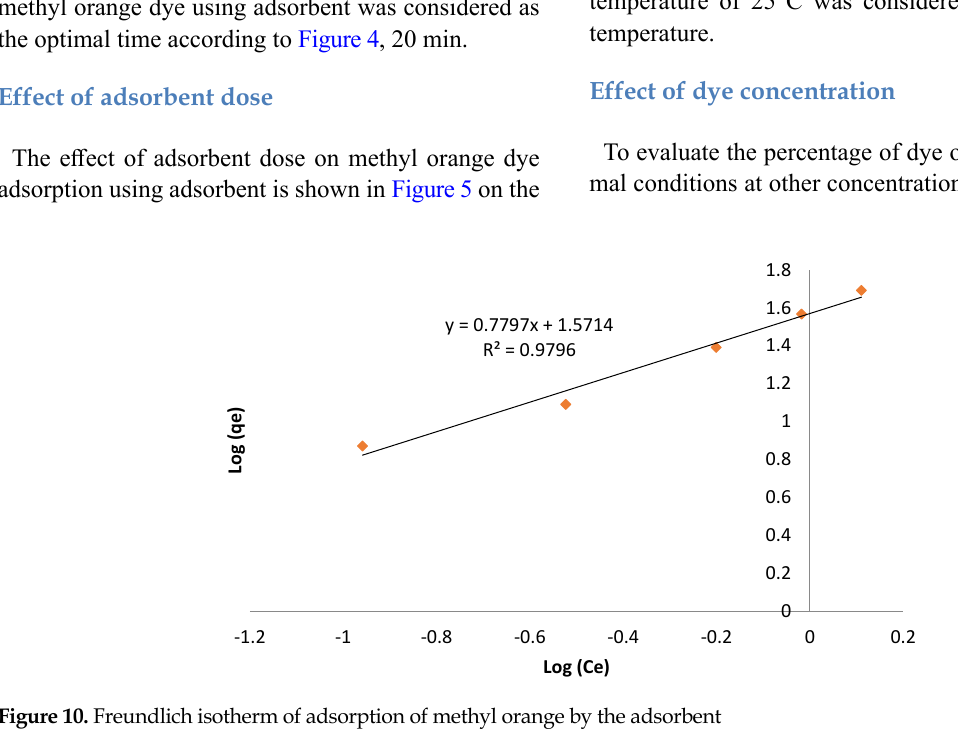
Figure 10. Freundlich isotherm of adsorption of methyl orange by the adsorbent